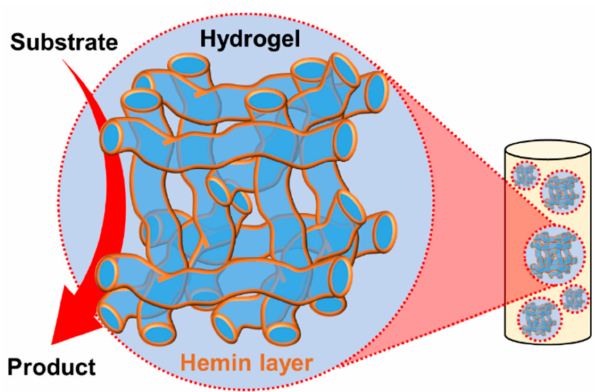
Figure 45. The principle of supramolecular-hydrogel-encapsulated hemin as an artificial peroxidase.